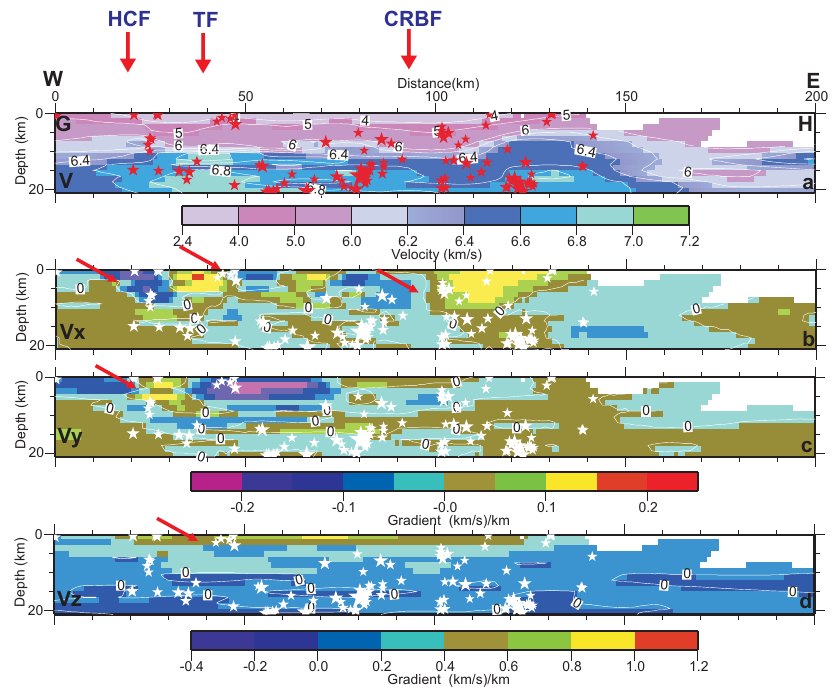
Fig. 5. Profile GH. Vertical cross-section of (a) tomographic velocity model (b) X gradient of velocity model, (c) Y gradient of velocity model, and (d) Z gradient of velocity model. Abbreviations as in Fig. 1.